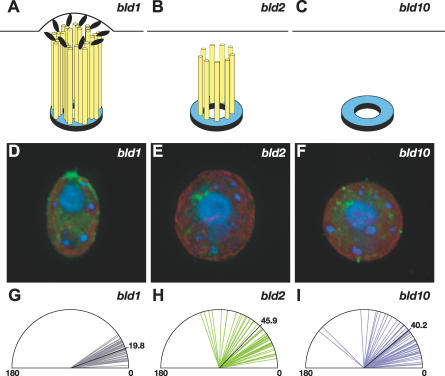
Mutant Centrioles with Defective Distal Ends Are Mispositioned(A) Centrioles contain nine triplet microtubule blades (yellow) arranged around a central cartwheel that sits on an amorphous disc structure (blue). At the most distal ends of centrioles in the region just proximal to the site of flagellar assembly, transition fibers are assembled (black ellipses) near the apical membrane. bld1 mutant cells have normal centrioles and transition fibers, but are defective in flagellar assembly due to a loss of intraflagellar transport.(B) bld2 cells are defective in centriole assembly and lack the B- and C-tubule of the triplet microtubule blades. As a result, the distal portion of bld2 centrioles is missing.(C) bld10 cells lack centriolar microtubules and have just the very proximal portion of the centriolar structure.(D) bld1 centrioles (green represents centrin/acetylated tubulin labeling) localize to the apical membrane.(E and F) bld2 and bld10 cells have mispositioned centrioles (green) that appear in the cell interior. They are still found closely apposed to the nucleus (blue).(G) bld1 cells have normally positioned centrioles (mean θcentriole = 19.8 ± 8.0°, n =52) despite their lack of flagella. This demonstrates that neither flagella themselves, nor the intraflagellar transport machinery, is required for centriole positioning.(H) bld2 centrioles lack the distal region and are mispositioned (mean θcentriole = 45.9 ± 26.9°, n = 44).(I) bld10 centrioles are also mispositioned (mean θcentriole = 40.2 ± 30.8°, n = 46).